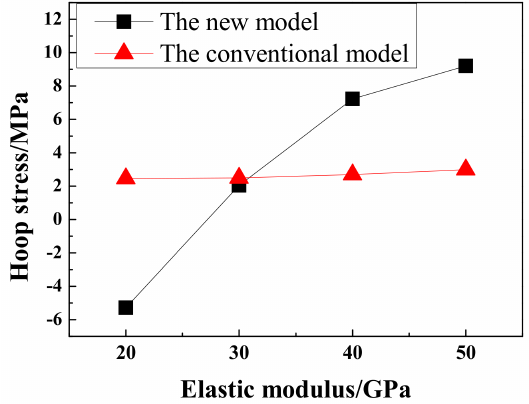
Figure 13. Hoop stress of cement sheath vs. cement sheath elastic